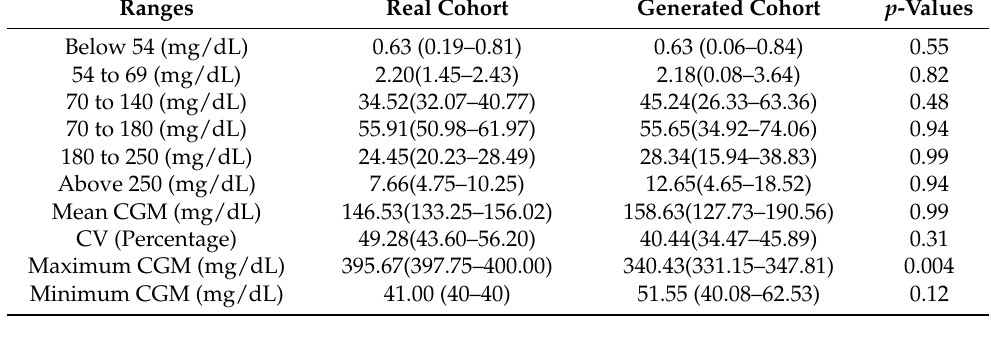
Table 2. A comparison of generated cohort and real cohort: Ohio T1D data set (6 patients).